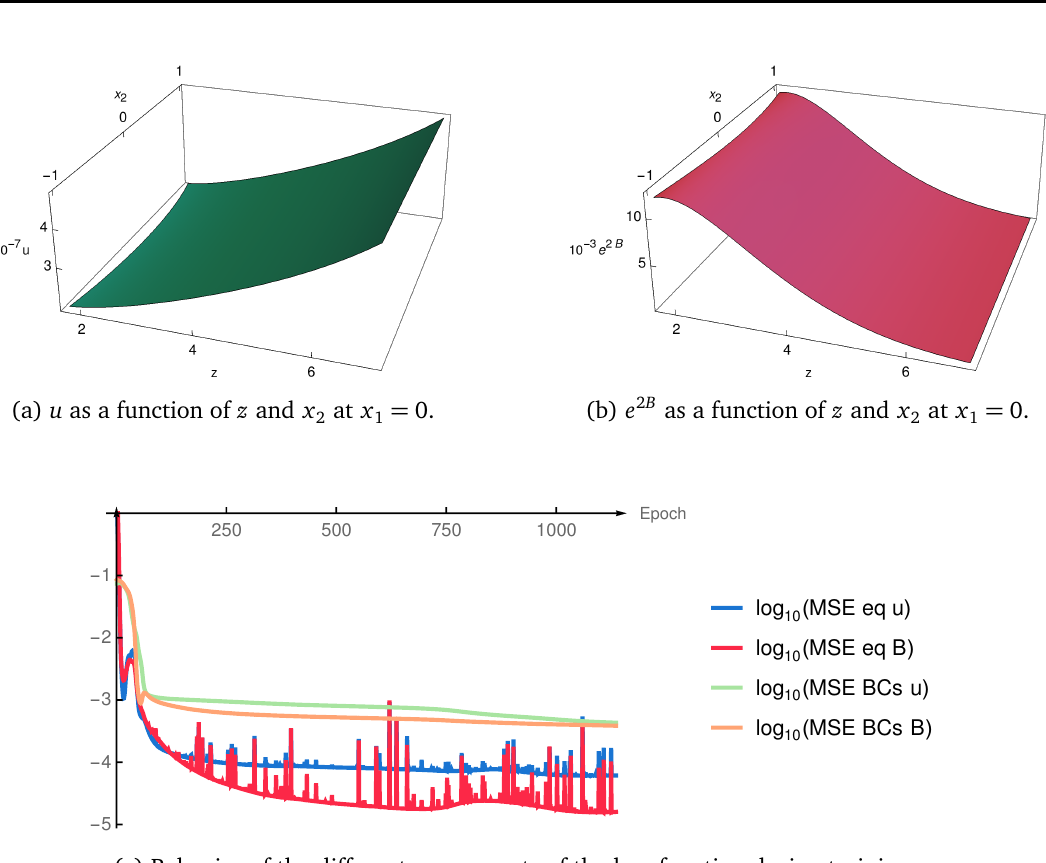
Figure 9: An approximate neural network solution to the internal PDEs. In panel 9a, 9b we show u and e 2 B as functions of the two-dimensional slice at x we show the behavior of the different components of the loss function (8.7) during the training